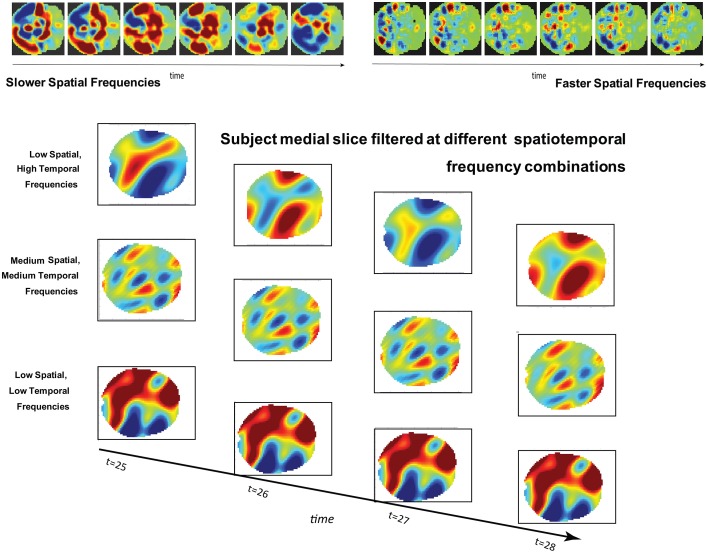
(Top): Simulated brain slice dynamics with random assignment of frequencies and phases to larger (left) and smaller (right) subregions of the slice. The active regions have similar behavior in both cases, but this behavior plays out on differently scaled spatial patterns in each. (Bottom): Four consecutive timeframes of one subject's medial slice data filtered at indicated combinations of spatial and temporal frequencies.